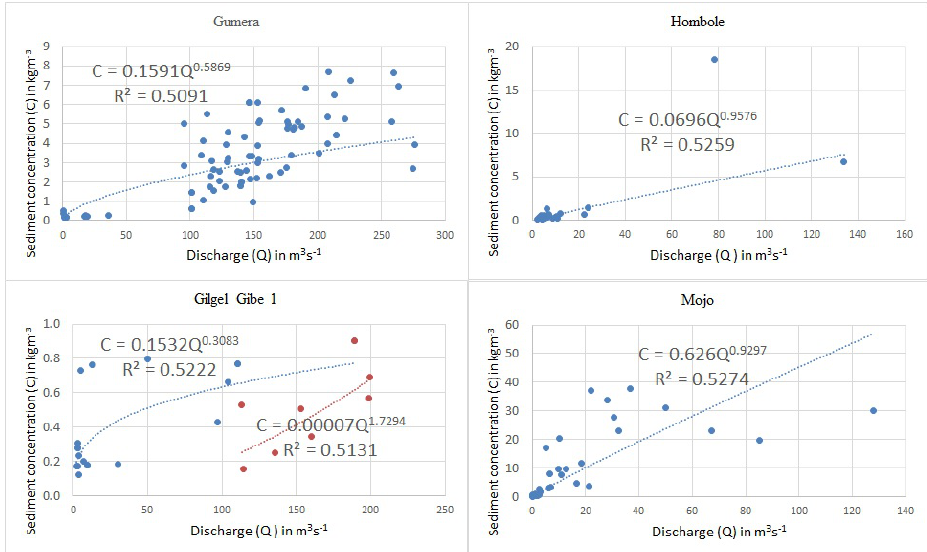
Figure 6. Sediment rating curve for each watershed under our